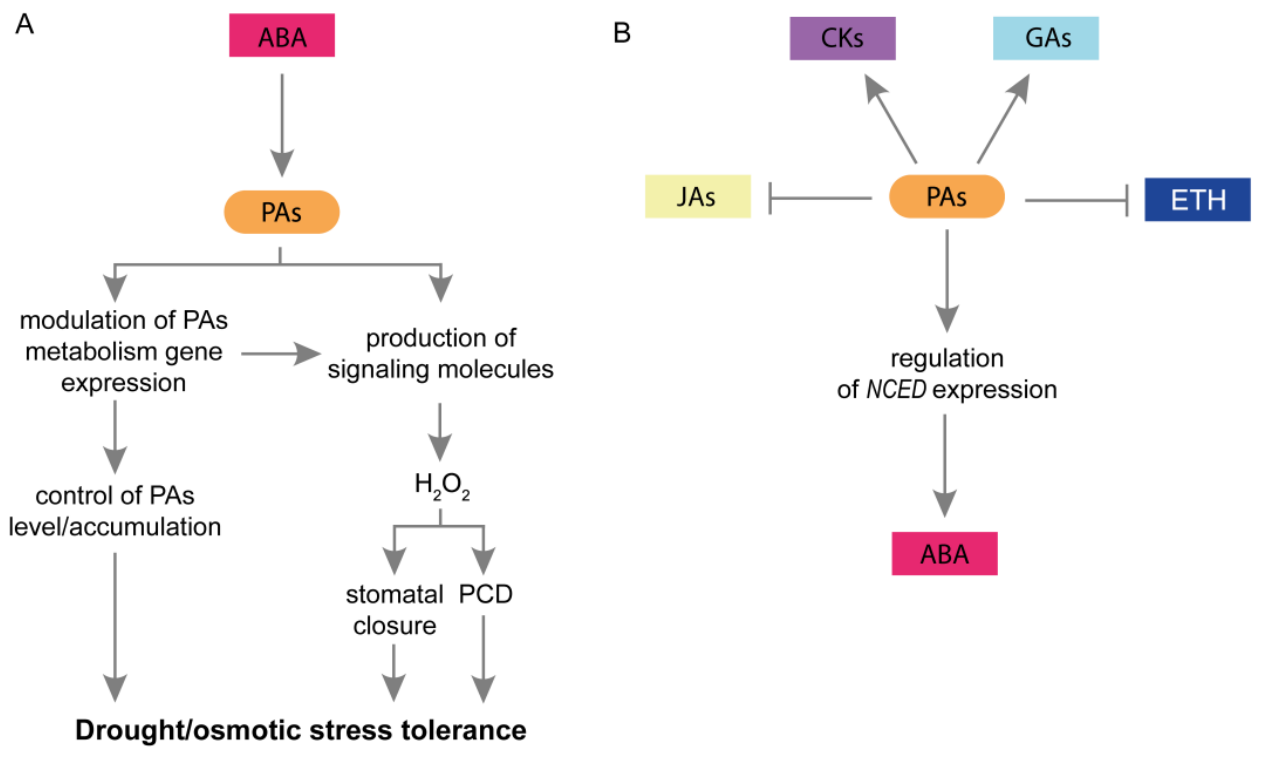
Figure 3. Interaction between PAs and plant hormones in response to drought and osmotic stress. ( A ) The effect of ABA on PAs’ mode of action. ABA modulates the expression of PAs metabolism genes and controls PAs content, thereby inducing plant tolerance to drought and osmotic stress.